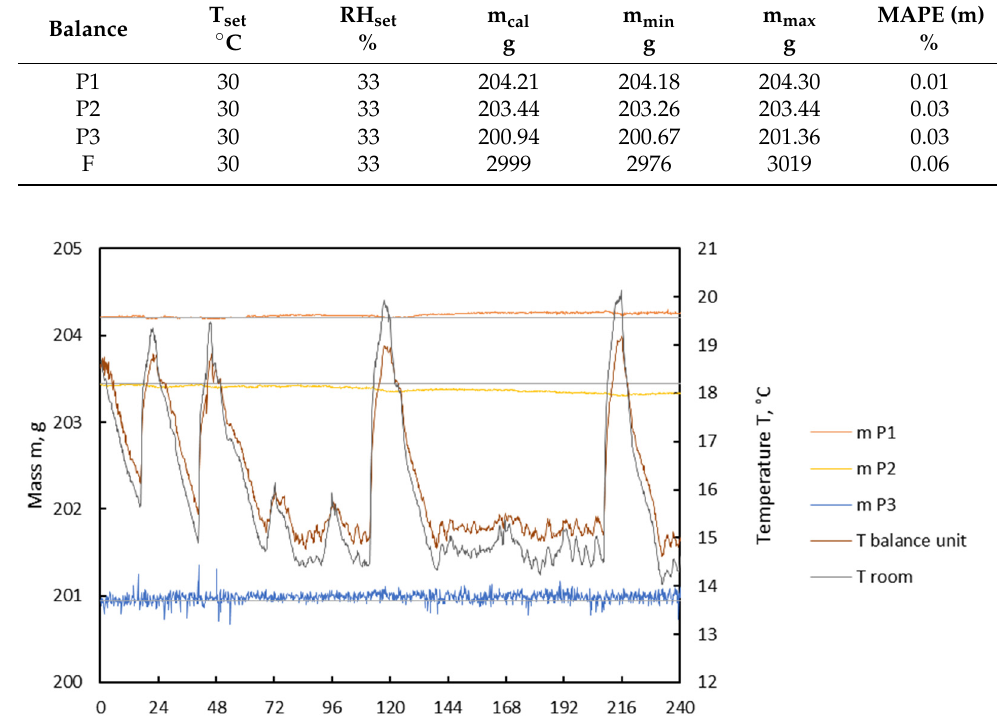
Figure 7. Room temperature and mass vs. time; room temperature (T room ) and sample mass of flat- bed drying zone (m F ) in the HPD TF3+ during calibration.